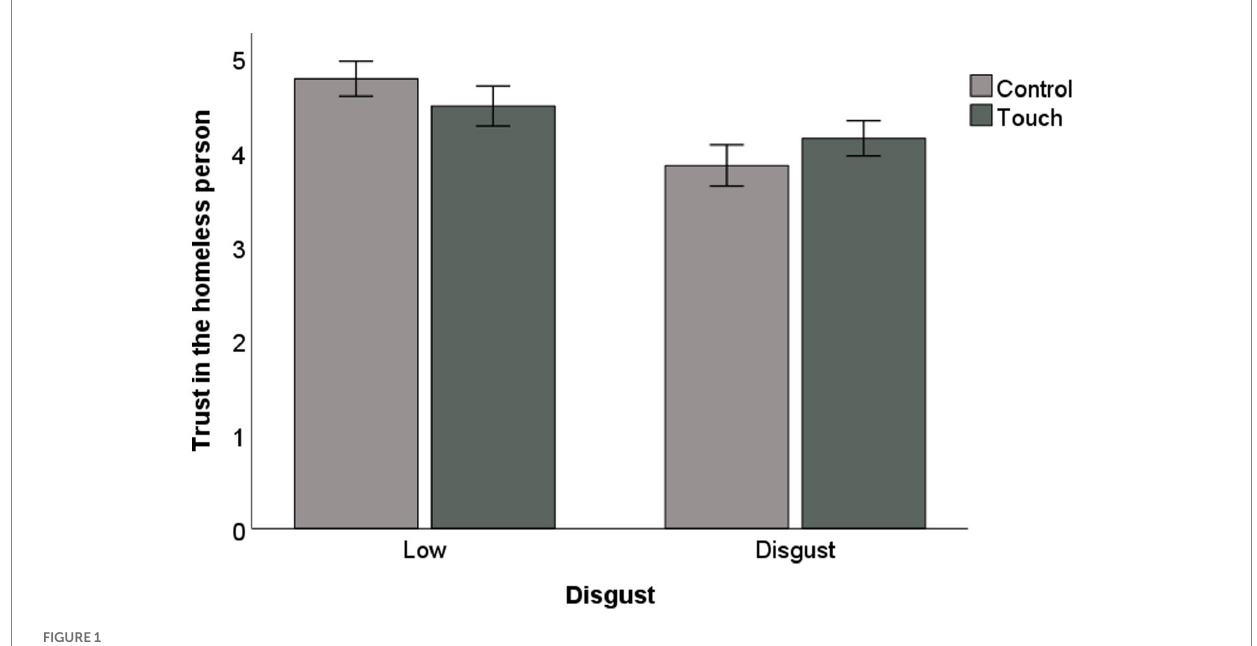
FIGURE 1 Study 1: Trust as a function of disgust and touch-related vocabulary.